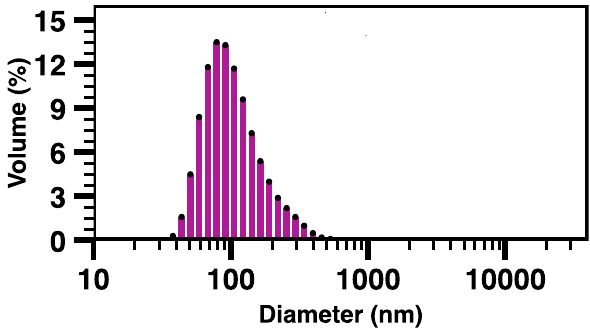
Figure 5. Volume-average size distribution for the PDC ( 5 ) micelles measured using dynamic light scattering (DLS).